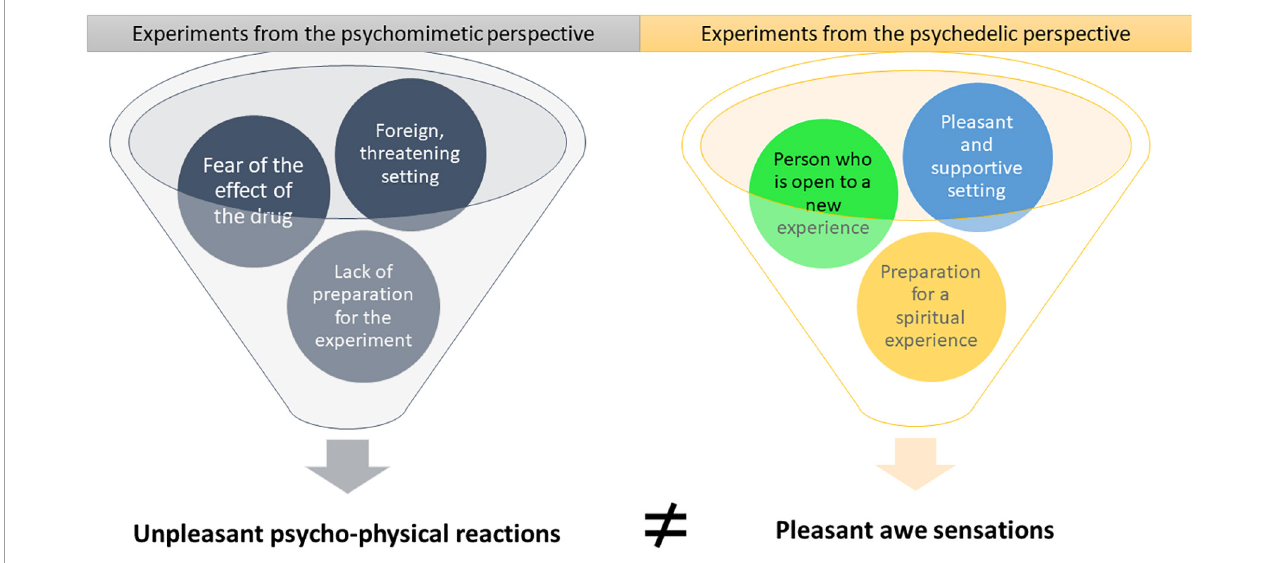
FIGURE2 Different perspectives lead to different set and setting, thus contradictory